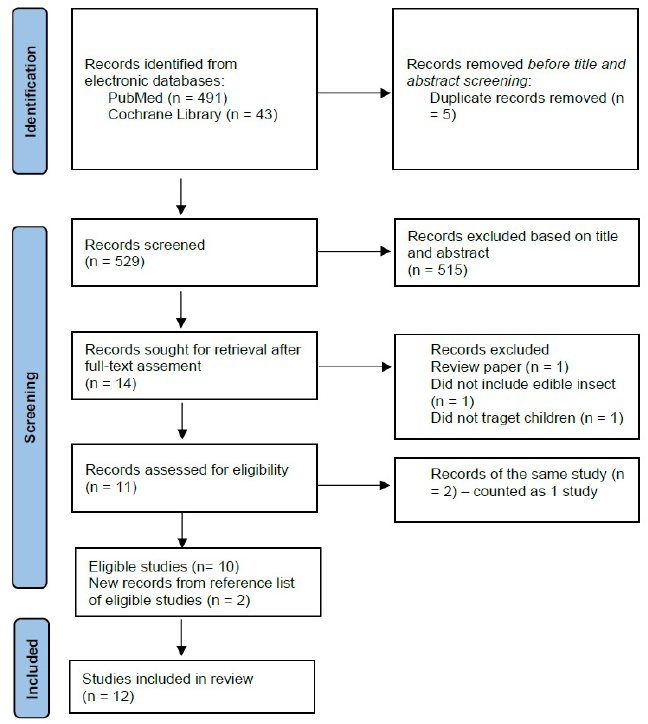
Figure 1. PRISMA flow diagram of selection of eligible studies.